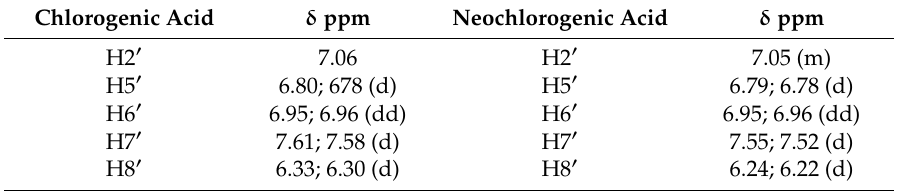
Figure 3. 1 H- 1 H COSY NMR spectrum for the green fruit extract showing H7 (cid:48) / H8 (cid:48) correlations for CGA and nCGA. Table 1. 1 H-NMR chemical shifts ( δ , ppm) for chlorogenic acid and neochlorogenic acid in